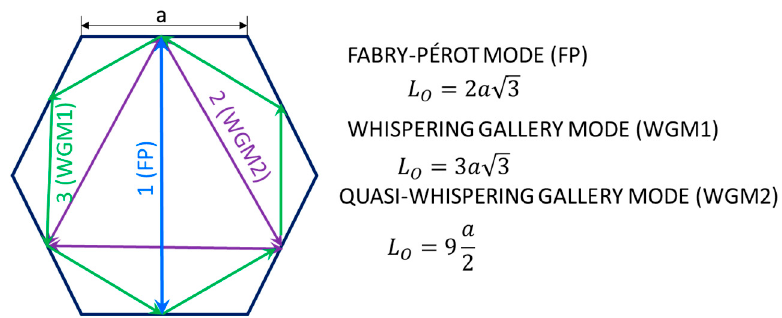
Figure 1. Scheme of the different resonant optical modes that can be supported in a hexagonal cavity.